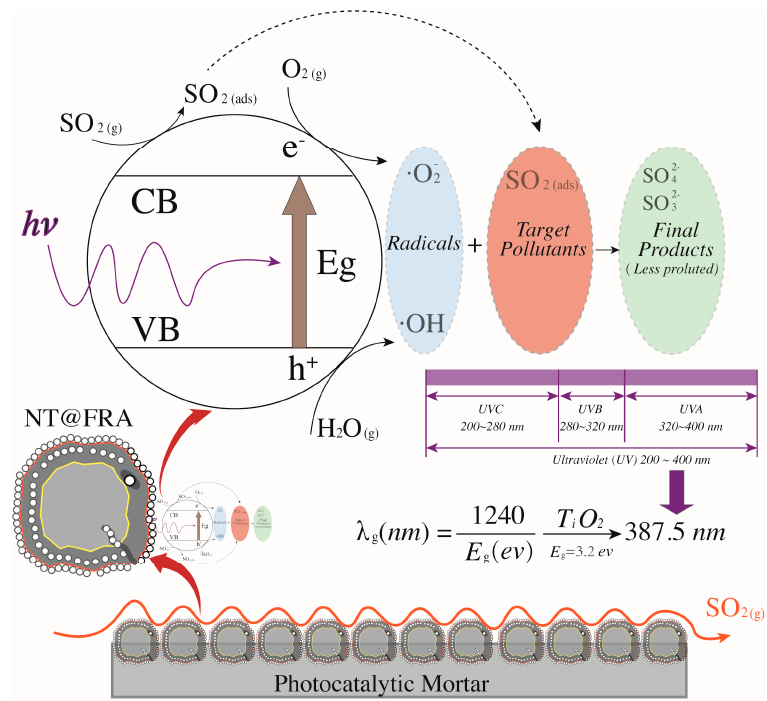
Figure 9. The reaction mechanism of photocatalytic oxidation of sulfur dioxides.